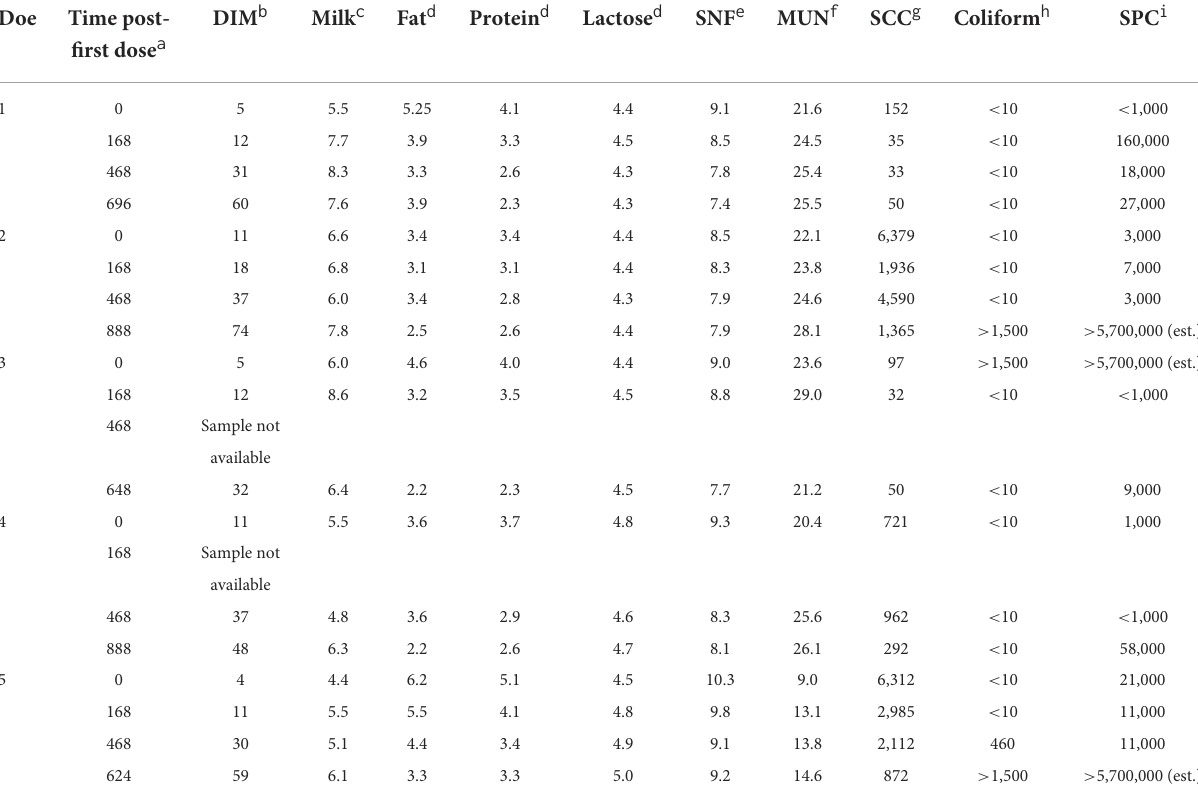
TABLE 3 Milk components and quality results for does ( n = 5) enrolled in a florfenicol milk residue depletion study. Samples were collected at each time point post-first dose a .